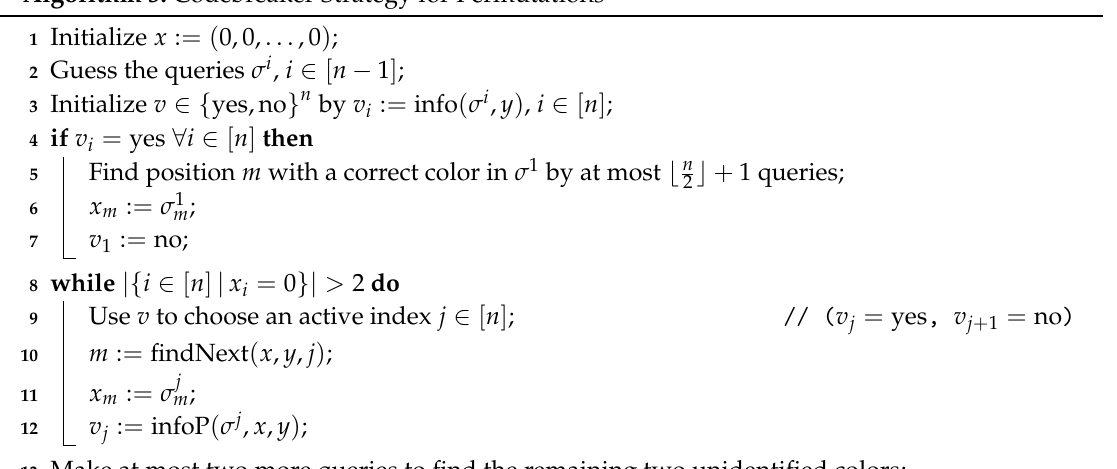
Figure 2. Panel ( a ): secret code y and partial solution vector x . Panel ( b ): the initial queries σ j and their responses infoP ( σ j , x , y ) , indicating if a query and the secret code coincide in any position that has not been identified, yet (i.e., in any 0-position of x ). Panel ( c ): binary search queries to identify the next secret position. The highlighted subsequences correspond to the subsequences of the initial queries that have been selected to apply the binary search. Algorithm 3: Codebreaker Strategy for